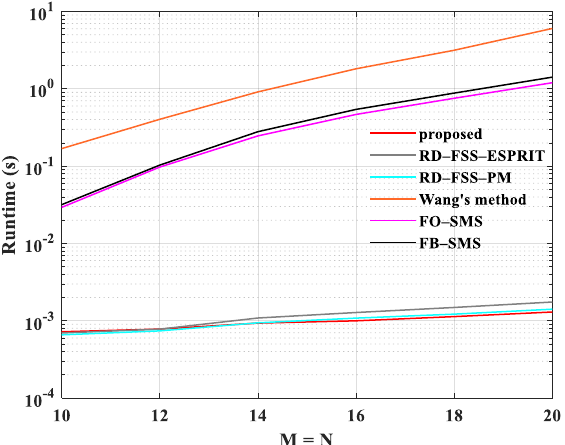
Figure 9. Runtime comparison versus array elements M = N